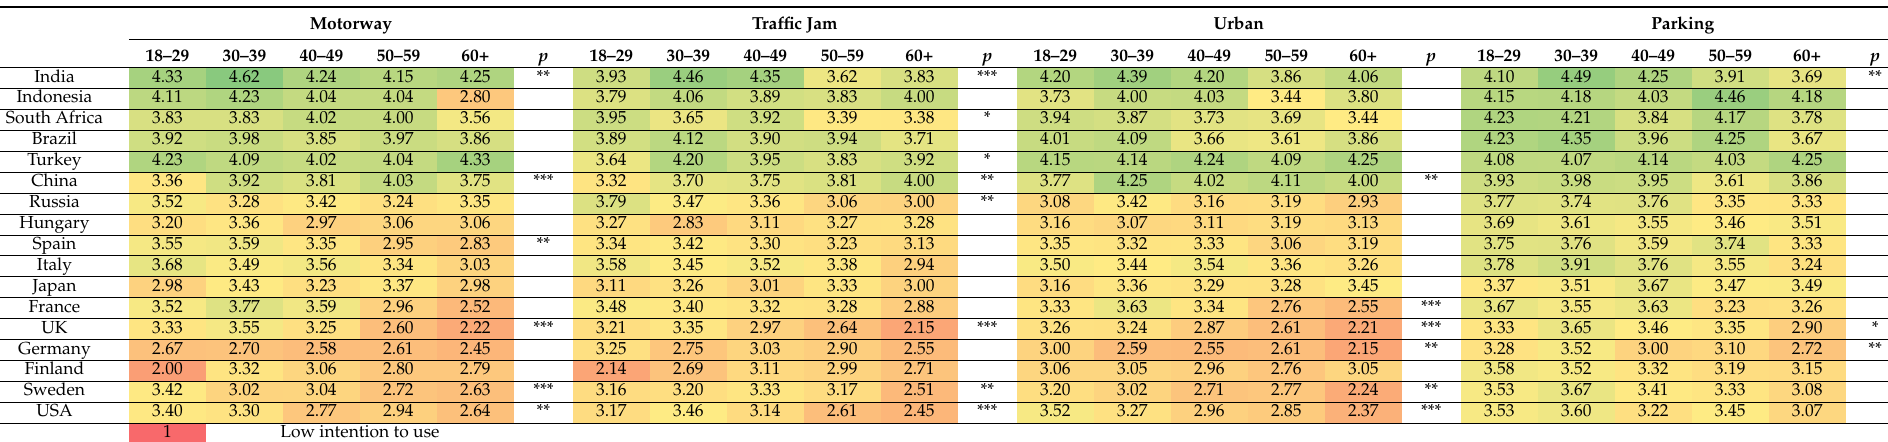
Table 8. Mean intention to use scores across countries (ordered from lowest to highest GDP; [33]) and for different ADFs and age groups. See below figure for colour scale. * p < 0.05, ** p < 0.01, *** p <